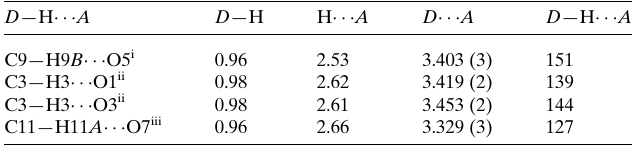
Table 1 Hydrogen-bond geometry (A˚ , (cid:2)